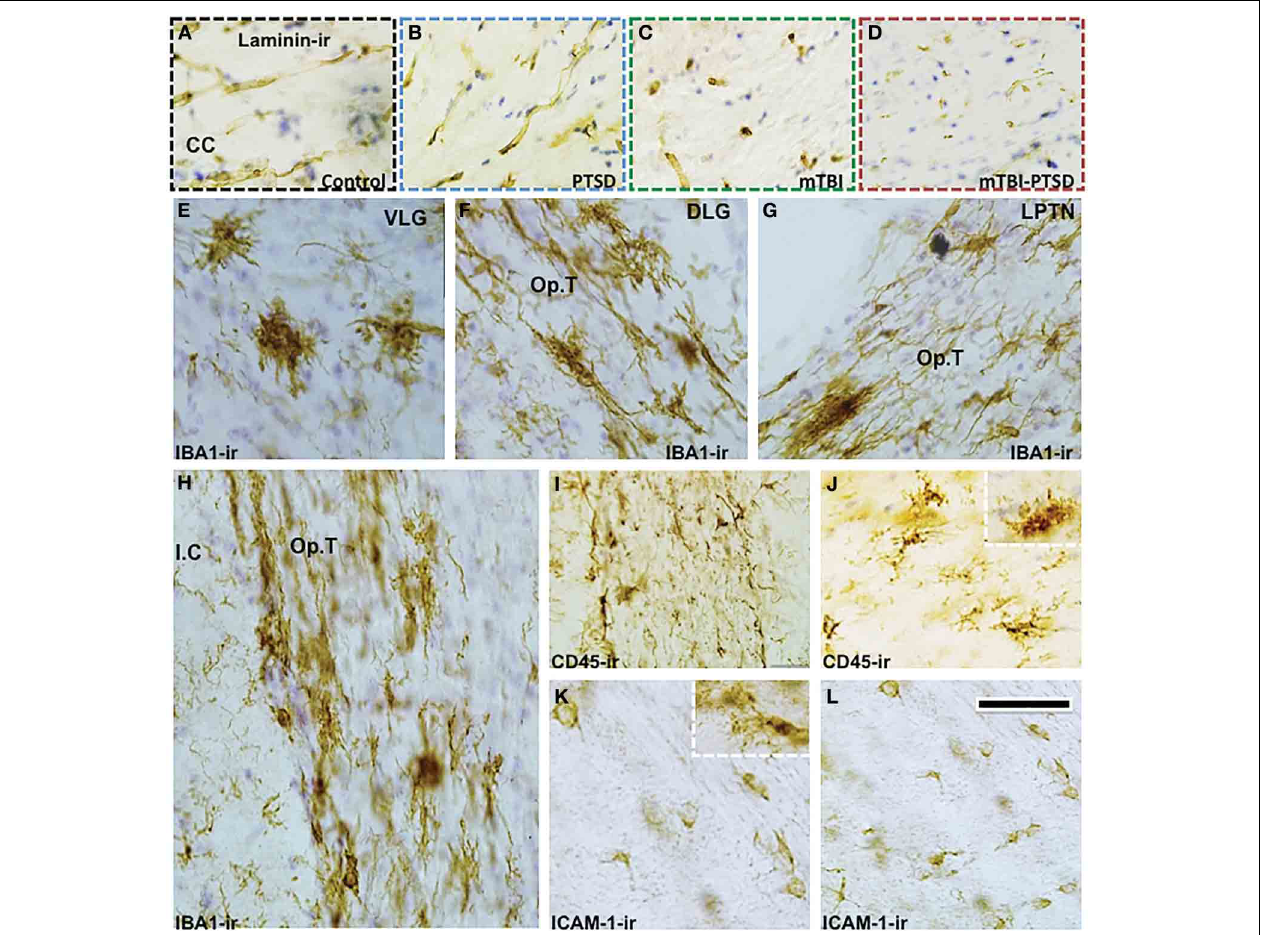
FIGURE 11 | Distinct white matter pathology and microglia response to mTBI. There was an apparent reduction in the immunoreactivity of extracellular matrix protein—Laminin in the corpus callosum (CC) of mTBI and mTBI-PTSD animals (A–D) . Microglia response to injury is shown with IBA-1 and CD45 antibodies. IBA-1 staining depicted an increase in microglial activation in white matter/neighboring regions of injured animals (E–J) . These regions included the ventral lateral geniculate nucleus (VLG) in (E) , the optic tract (Op.T) projections surrounding the dorsal lateral geniculate nucleus